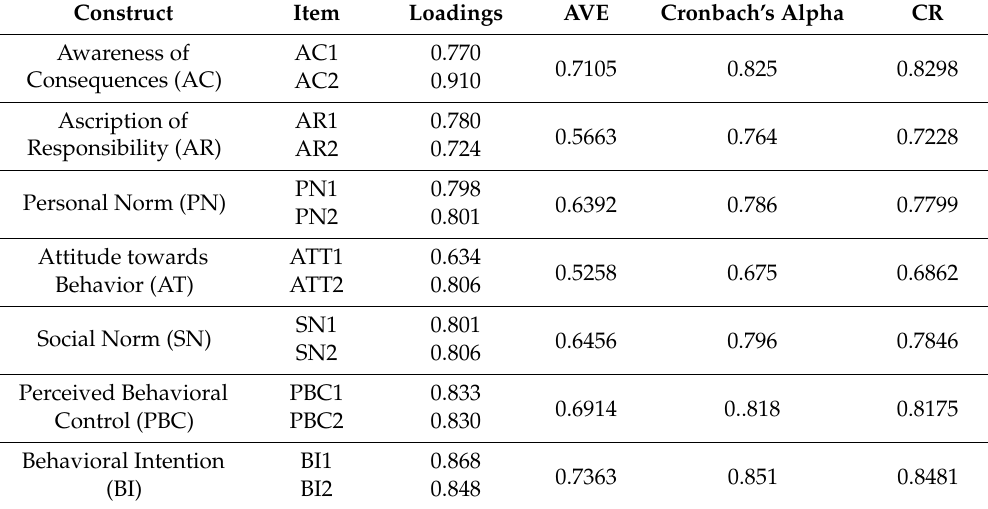
Table 2. Variable factor analysis and reliability and validity test results.